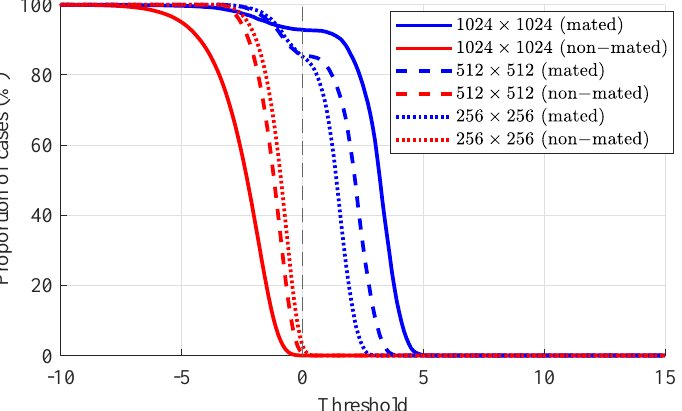
Figure 7. Tippet plots for pictures at different resolutions: 1024 × 1024, 512 × 512 and 256 × 256. Cumulated distributions of mated (blue) and non-mated (red) scores are presented.